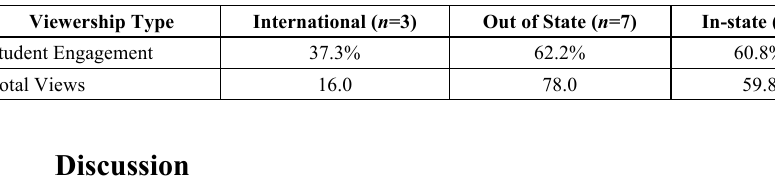
Table 3. Student viewership habits based on